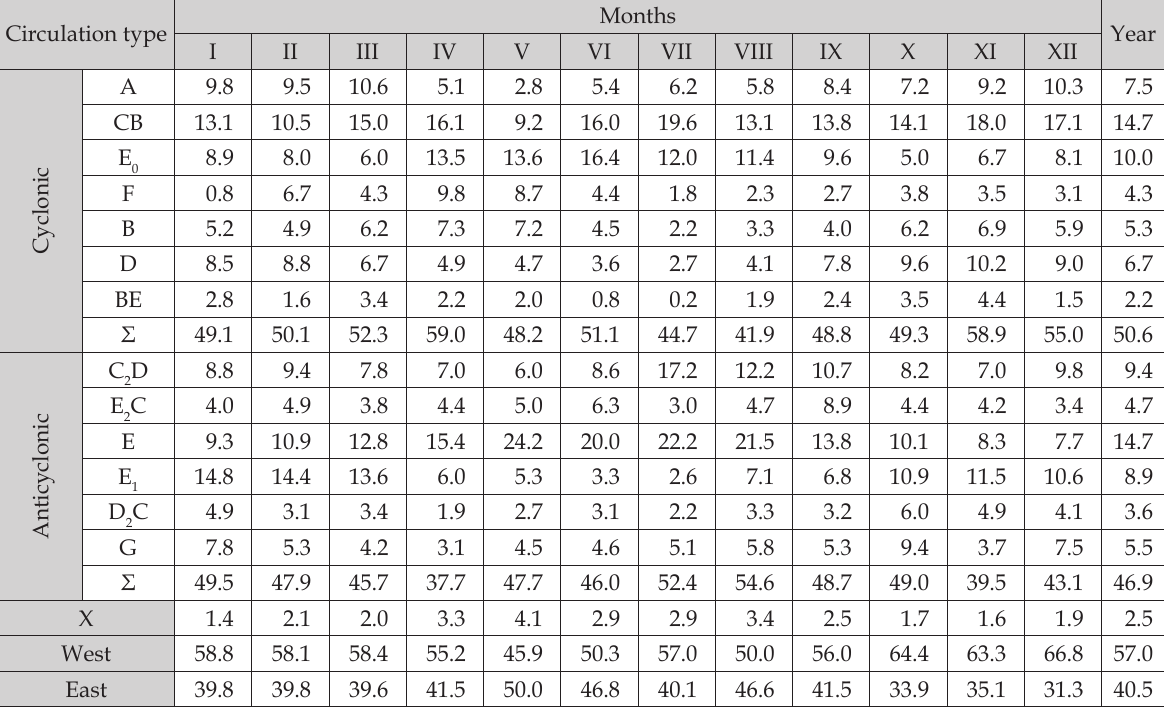
Table 4. Frequency of occurrence (%) of atmospheric circulation types according to Osuchowska-Klein (1966–1998). Circulation